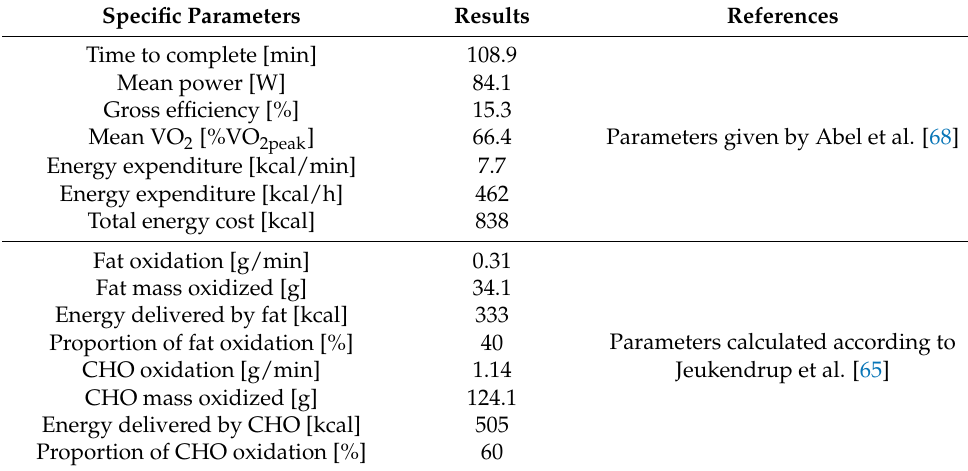
Table 1. Model calculation of the metabolic costs associated with performing a handbike